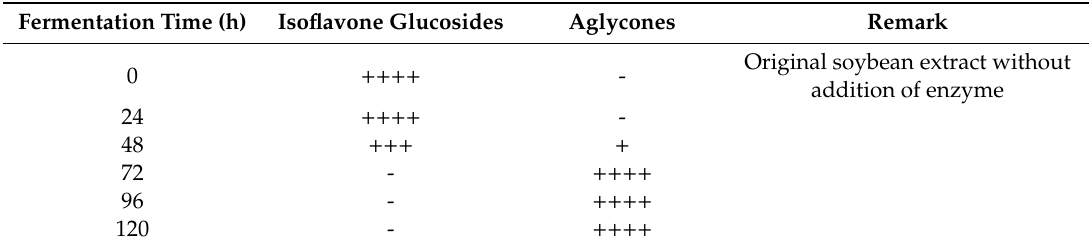
Table 1. E ff ect of hydrolysis time of soybean residual extract on isoflavon glucosides and aglycones formation by P. citrinium at 30 ◦ C.